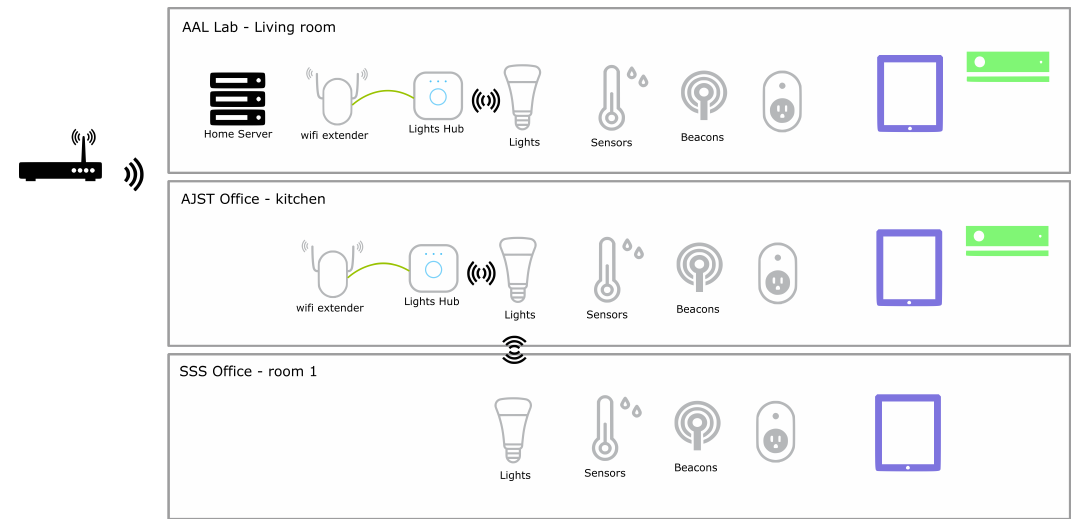
Figure 12. Smart home physical installation, showing the several sensors and devices deployed at each of the 3 spaces integrated the virtual